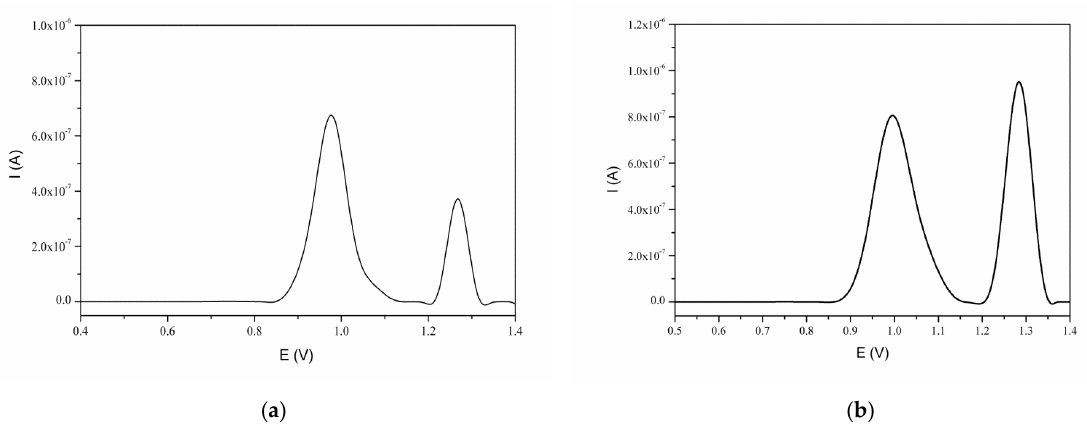
Figure A3. Average electrochemical signal of oligonucleotide: 5′GCTCGGTACGGAAGTTGAC ( a ) and calf thymus DNA ( b ).